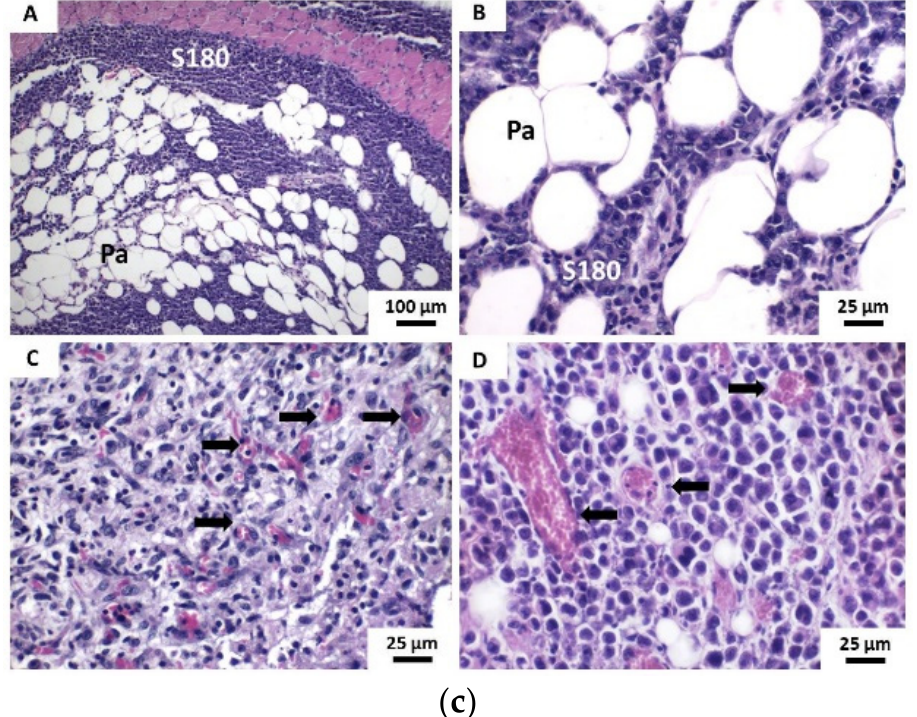
Figure 5. ( a ) Photomicrographs of histochemical technique (HE)-stained histological sections show the main histopathological features of tumors developed in the Vehicle group from the implantation of S100 cells. (A) The dermal superficial margin of the tumor shows discontinuous pseudocapsule (Cap) showing evident neoplastic infiltration (white arrows) (40 × ) and (B) extensive areas of coagulative necrosis (Ne) within the neoplastic cell blocks (40 × ). (C) Detail of tumor cells exhibit intense atypia and promote dissociation and destruction of striated skeletal muscle fibers (black arrows) (400 × ) and (D) Bizarre giant tumor cell (400 × ); ( b ) (A) Neoplastic cells promote infiltration and massive destruction of striated skeletal muscle fiber bundles (100 × ), (B) Strongly dissociated tumor cells arranged in “Indian row” cords (400 × ). (C) Neoplastic cells promote perineural invasion of peripheral nerve fibers (Fne) (100 × ). (D) Neoplastic cells observed inside the lymphatic vessel form a tumoral embolus (red outline) (100 × ) and ( c ) (A) and (B) Neoplastic cells (S180) promote massive infiltration of the hypodermic adipose panicle (Pa) (100 × and 400 × , respectively). (C) Intense capillary vascular neoformation (black arrows) on the periphery of the tumor and (D) in intraparenchymal areas (400 × ). POH/ β -CD 50 mg/Kg group presented histological characteristics similar to those evidenced in the 5-FU group, expressed by an architectural arrangement of tumor cells also in irregular pseudolobules, now separated by edematous fibrous connective tissue and rich in inflammatory cells, sometimes separated by necrotic trabeculae tissue. It was observed that the proportion of areas of coagulative necrosis shown in this group was higher than in the 5-FU group (Figure 7a). The invasion pattern of striated skeletal muscle tissue and subcutaneous adipose panicle by tumor cells was also similar to the 5-FU group, with tissue dissociation in dense and compact blocks of muscle fibers and fat cells. Mitotic activity was still marked but seldom atypical mitosis (Figure